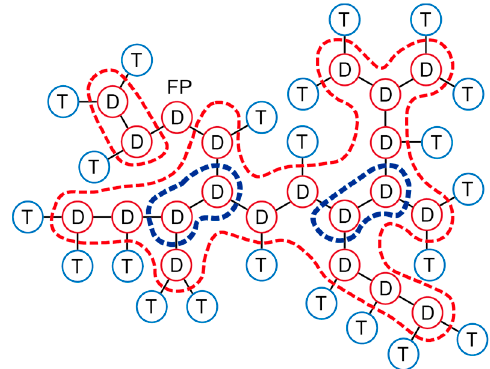
Figure 8. Example of the hyperbranched polymer architecture generated in the present MC simulation for a CSTR with r = ∞ and ξ = 0.2. The tri-branched clusters of the first order are represented by the groups enclosed by the red broken curves, while the tri-branched clusters of the second order by the blue broken curves. For this polymer, P = 43, D = 21, and DB = 1. Figure 9 shows the relationship between P LC,2 and P for batch and CSTR with r = ∞ . For a CSTR, ξ = ξ UL = 0.25, and x A = 0.95 for batch polymerization. In the case of a CSTR, P LC,2 increases with P , and